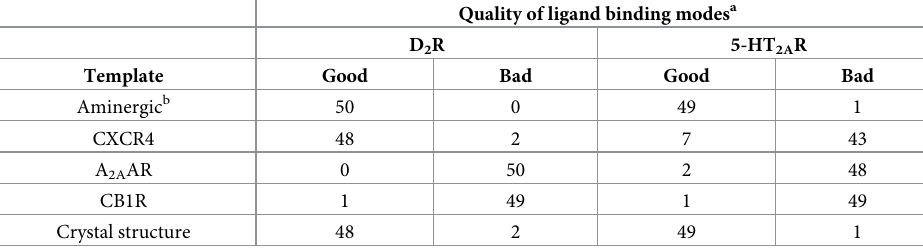
Crystal structure a Binding modes that captured a charge-charge interaction with Asp 3.32 and extended towards TM5 with an aromatic moiety were classified as “Good”. Binding modes that failed to fulfil one of these criteria were classified as “Bad”. b Template with the highest TM and BS sequence identity to the D 2 R (D 3 R) and 5-HT 2A R (5-HT 2C